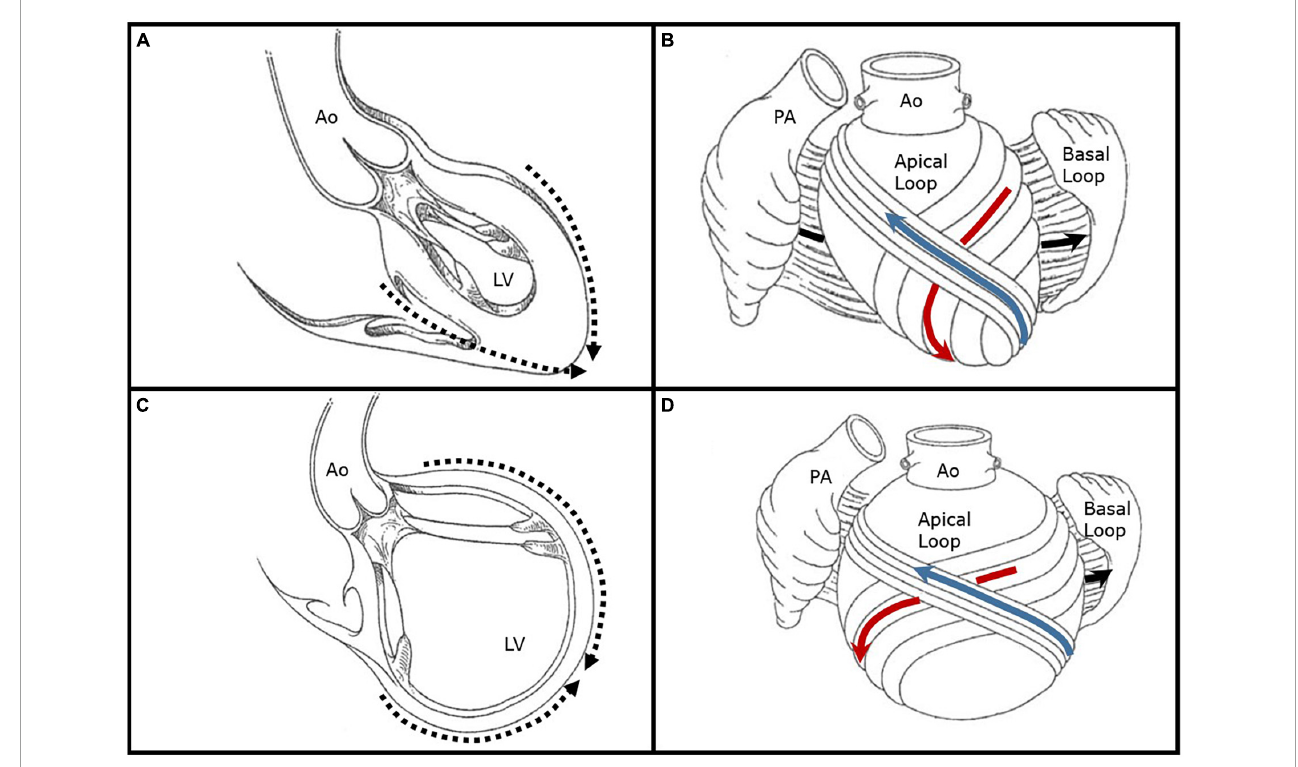
FIGURE1 Illustrative representations of left ventricular remodeling and alteration in chamber shape and myofiber orientation. (A) Depicted is a left ventricle with a normal elliptical shape forming an apical cap (dashed arrows) with preserved papillary muscle orientation. (B) The basal ventricular loop is depicted open with circumferential fibers in a transverse orientation (black arrow) which surround an inner apical loop helix. The descending limb of the apical loop (red arrow) converges into a vortex at the apical cap which then crosses superficially to form the ascending limb (blue arrow). The myofibers of the apical loop limbs are oriented obliquely at approximately 60 ◦ angles, and their normal shortening of 15% produces an ejection fraction of 60%. (C) Depicted is a remodeled left ventricle with a spherical shape and lack of a true apex (dashed arrows). The chamber is markedly dilated and there is papillary muscle displacement. (D) In the setting of left ventricular dilatation and sphericity, the apical loop myofibers are stretched and adapt a transverse orientation similar to the basal loop. Transverse, or circumferential, fiber shortening generates an LV ejection fraction closer to 30%. Figures are adapted with permission from Buckberg et al. (19). Ao, aorta; LV, left ventricle; PA, pulmonary